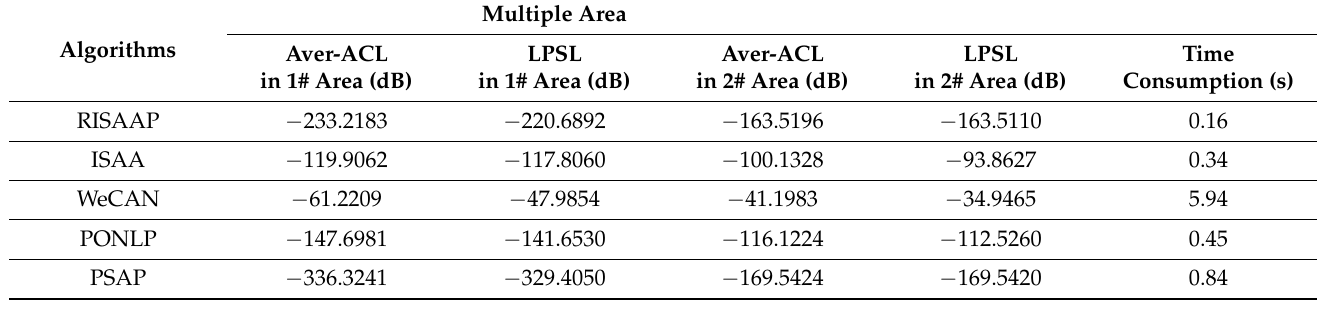
Table 2. Performance comparison for suppressing multiple area sidelobes with different weights.